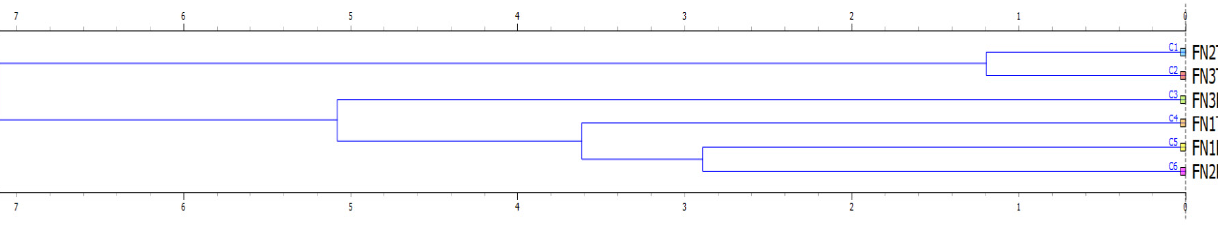
Figure 7. Dendrogram showing the hierarchical clustering of the forest nurseries and tillage systems based on the root volume (target variable), as a function of the physical properties of the soils before sowing (transplanting). Legend: abbreviations of the right side of the figure are explained in Table 3 and exclude the species, horizontal axis stands for the Euclidian distance.